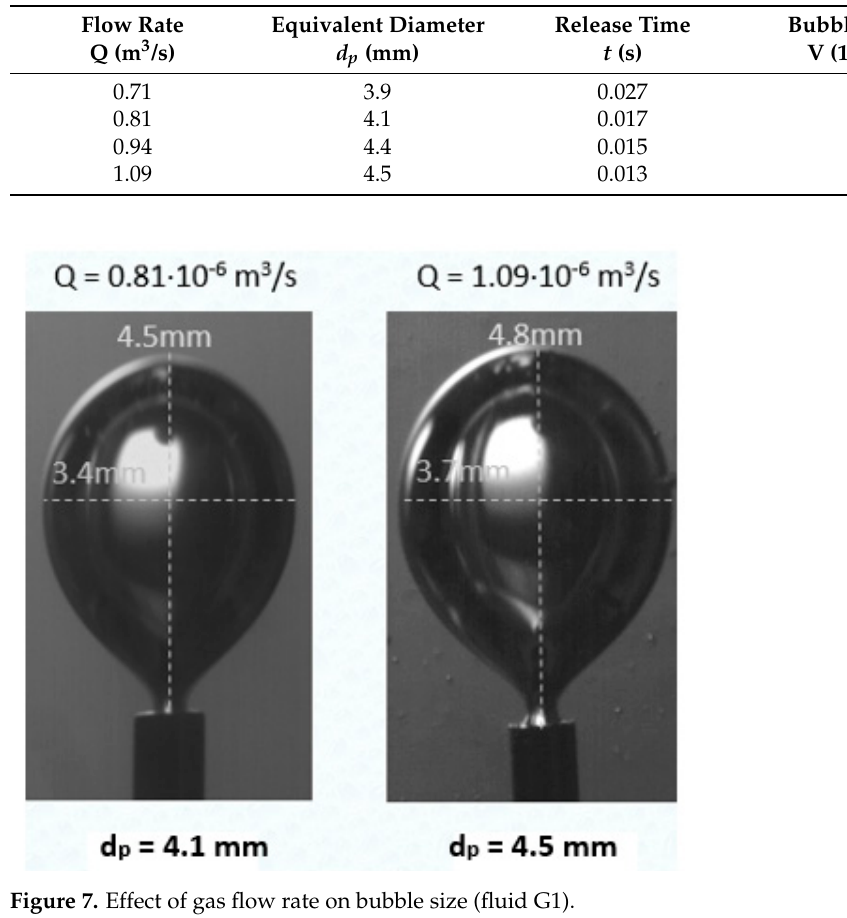
Figure 7. Effect of gas flow rate on bubble size (fluid